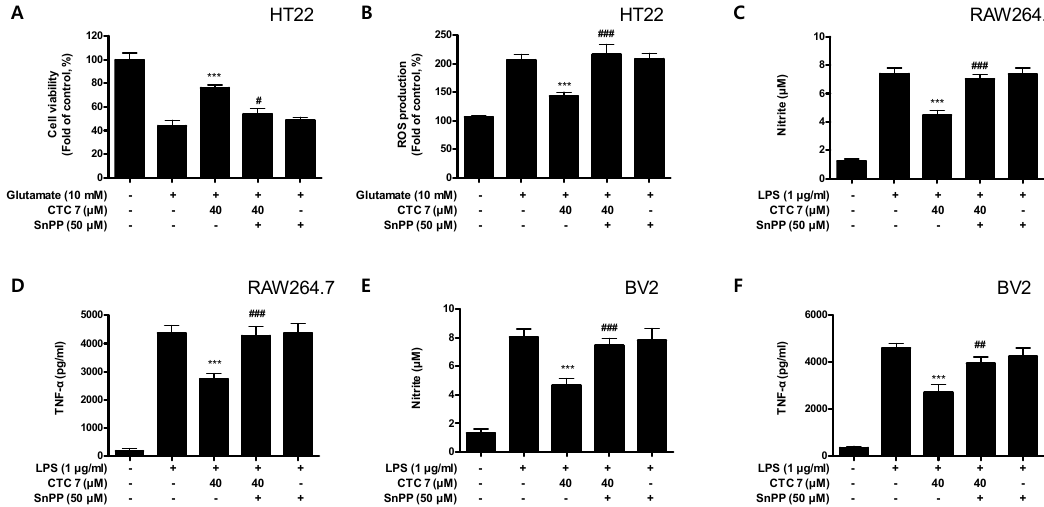
Figure 10. Effects of CTC 7 -induced Nrf2-mediated HO-1 expression on glutamate-induced oxidative neurotoxicity and ROS generation in HT22 ( A , B ) cells and LPS-stimulated proinflammatory mediator production in RAW264.7 ( C , D ) and BV2 ( E , F ) cells. HT22 cells were treated with CTC 7 (40 µ M) in the presence or absence of SnPP (50 µ M). ( A ) Cell viability and ( B ) ROS generation were measured following treatment with glutamate (10 mM) for 12 h. RAW264.7 and BV2 cells were pretreated with CTC 7 (40 µ M) for 3 h with or without SnPP (50 µ M), and subsequently stimulated with LPS (1 µ g / mL) for 24 h. Nitrite ( C , E ) and TNF- α ( D , F ) were assayed as described in the Materials and Methods section. Data are presented as the mean ± standard deviation for three independent experiments. *** p < 0.001 compared to the glutamate or LPS control; # p < 0.05, ## p < 0.01, ### p < 0.001 compared to CTC7 plus glutamate or LPS without SnPP.